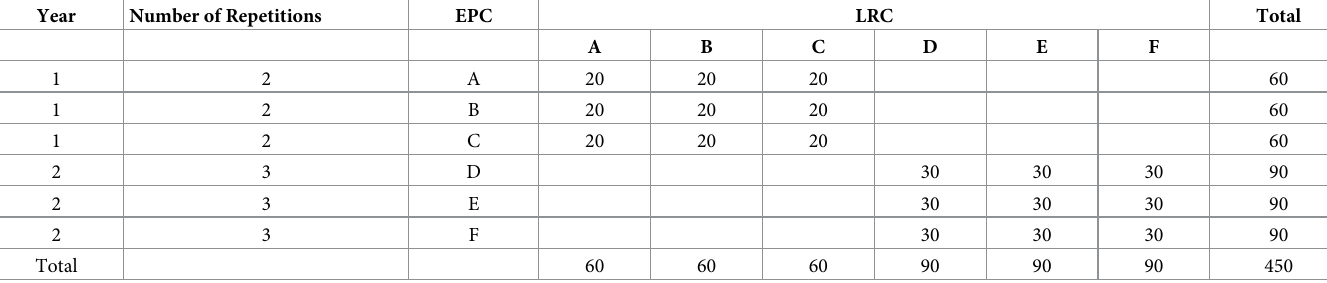
queen for 6 h on a comb with empty brood cells. The newly laid eggs were transferred to an incubator (35 ± 1˚C, 85% relative humidity), and at a standard age of 48 ± 3 h after egg laying, all of the eggs were weighed (Sartorius M5P) to the nearest microgram. To avoid possible arti- facts related to different non-genetic colony odors (e.g., a different nectar and/or pollen supply of the colonies), the larvae were artificially reared until an age of 48 h [25]. At this age, 450 lar- vae, with 30 from each EPC, were transferred into artificial queen cups and distributed equally in the corresponding LRCs. In each of the experiments, each LRC received 10 (related) larvae from its related EPC and 10 larvae from each of the two unrelated EPCs (Fig 1, Table 1). This design was repeated twice using the same EPC × LRC combinations in the first year. In the sec- ond year, the experiments were repeated three times (see Table 1 for details). The larvae that were not accepted for queen rearing were removed by the worker bees. The acceptance of lar- vae for queen rearing could be clearly observed based on the capping of the corresponding queen cells. Table 1. Distribution of larvae from the Egg Producing Colonies (EPC) between the Larvae Receiving Colonies (LRC). Year Number of